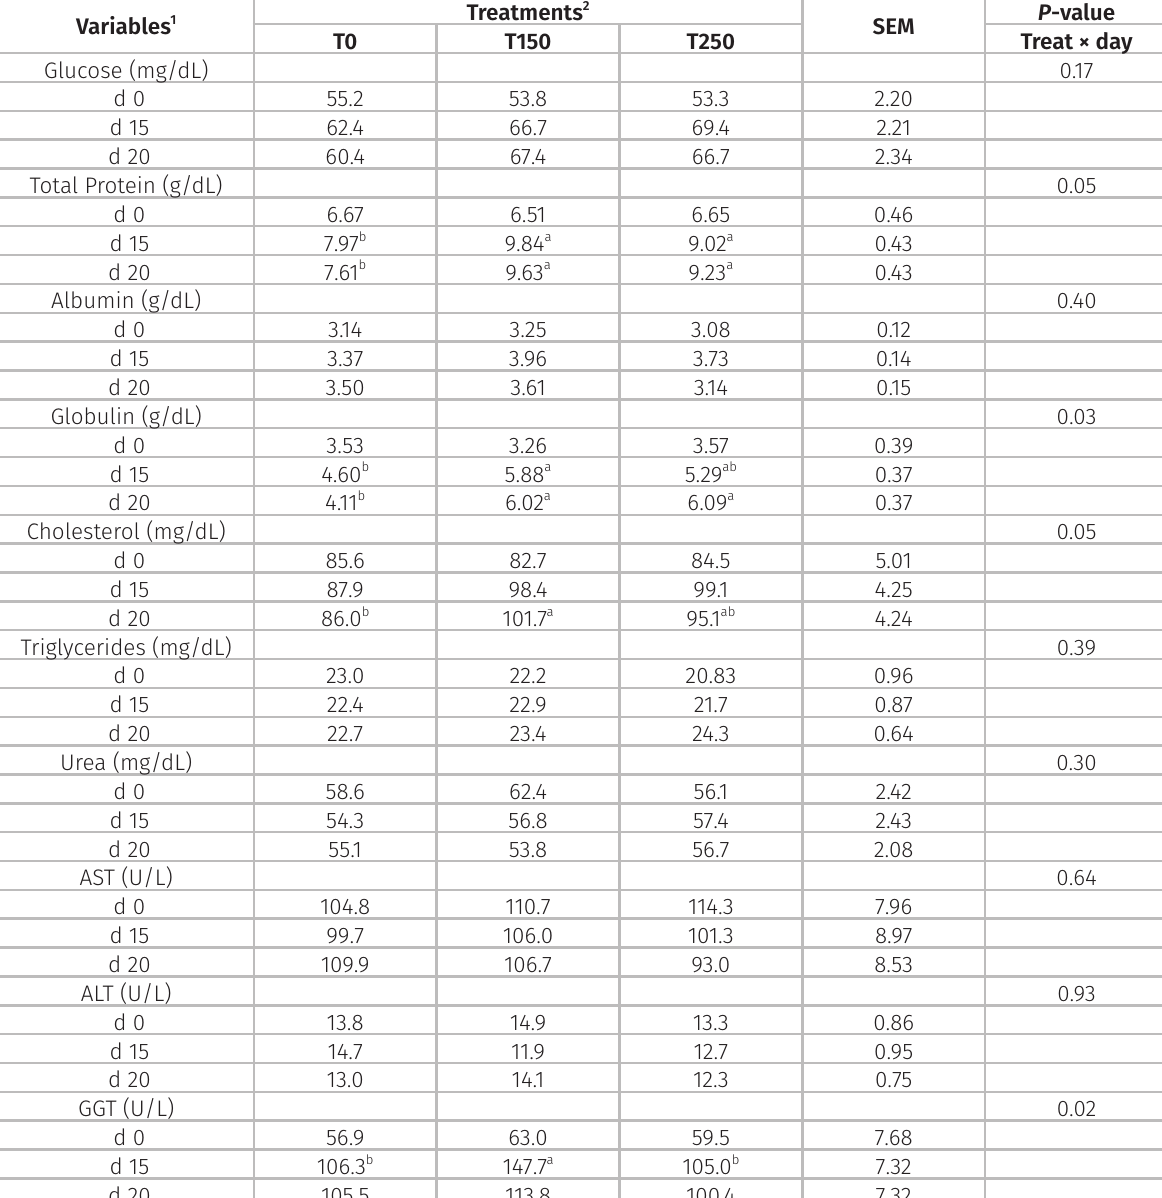
Table V. Serum biochemistry variables of Lacaune ewes supplemented with dietary phytogenic. Variables